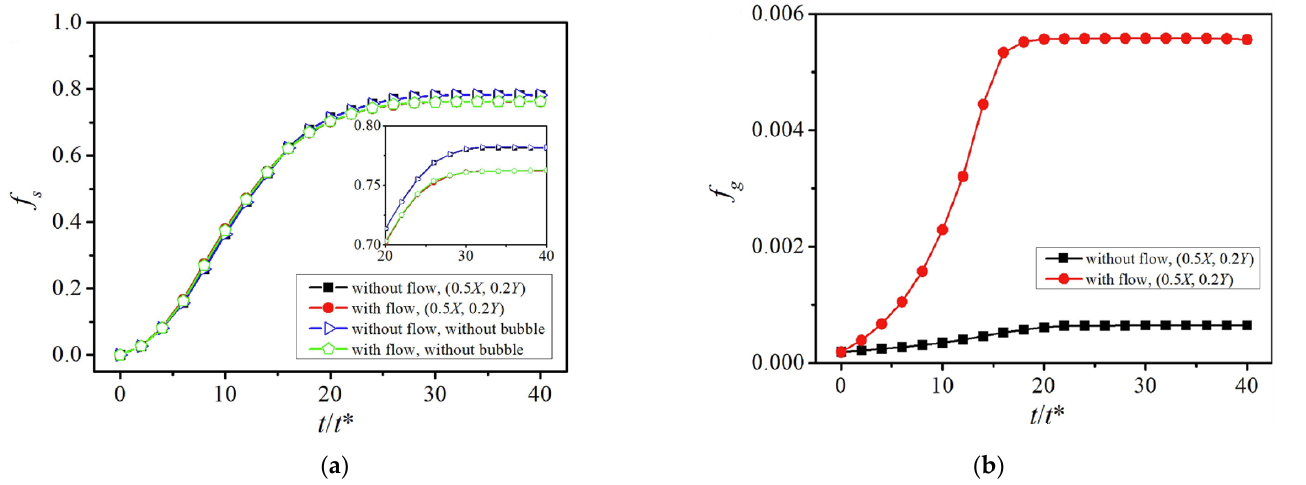
Figure 6. Phase fractions versus time under the two configurations corresponding to Figure 5: ( a ) solid fraction f s versus time, and ( b ) gas fraction f g versus time. Where t ∗ = 10 5 dt , dt is the time step [82].